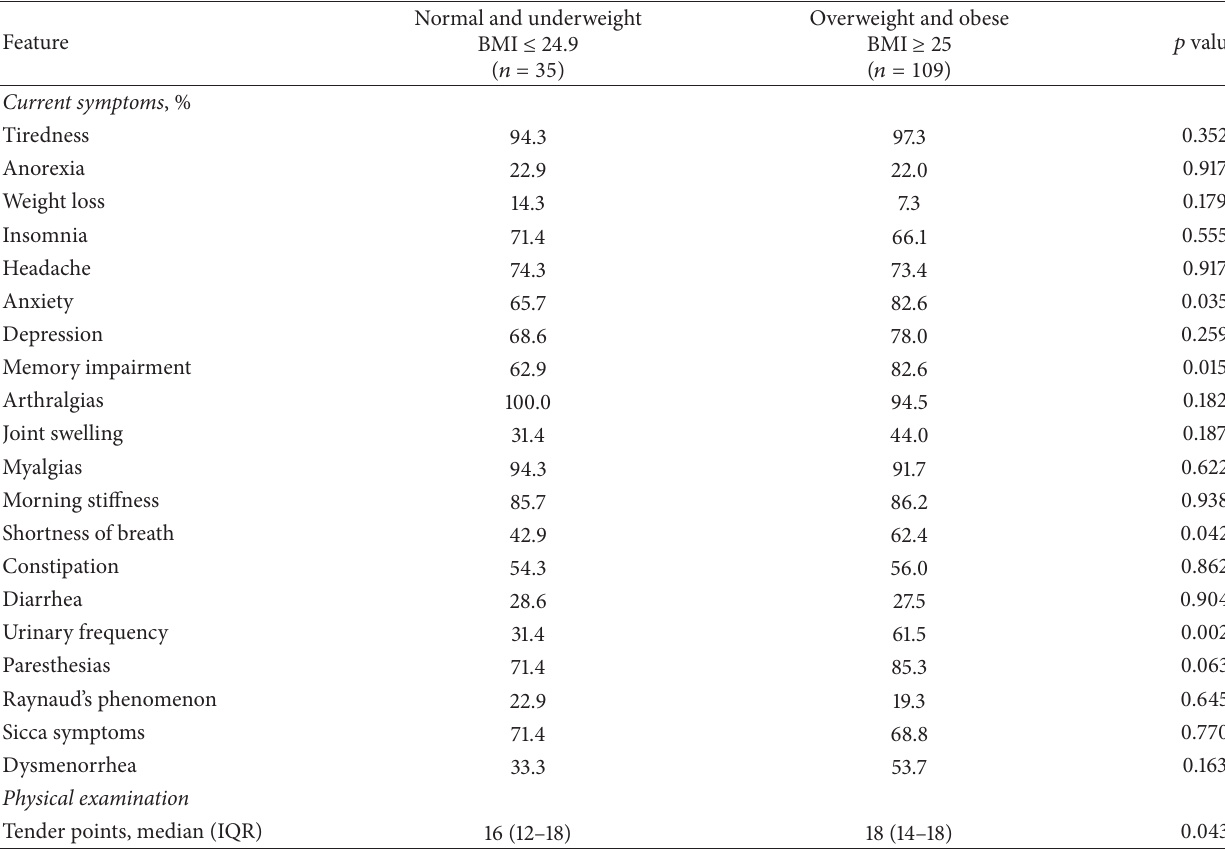
Table 2: Clinical manifestations in nonoverweight/obese and overweight/obese patients with fibromyalgia syndrome.